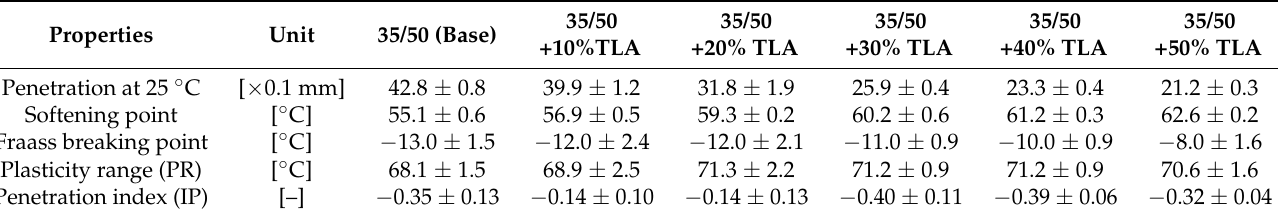
Table 3. Basic physical properties of TLA-modified